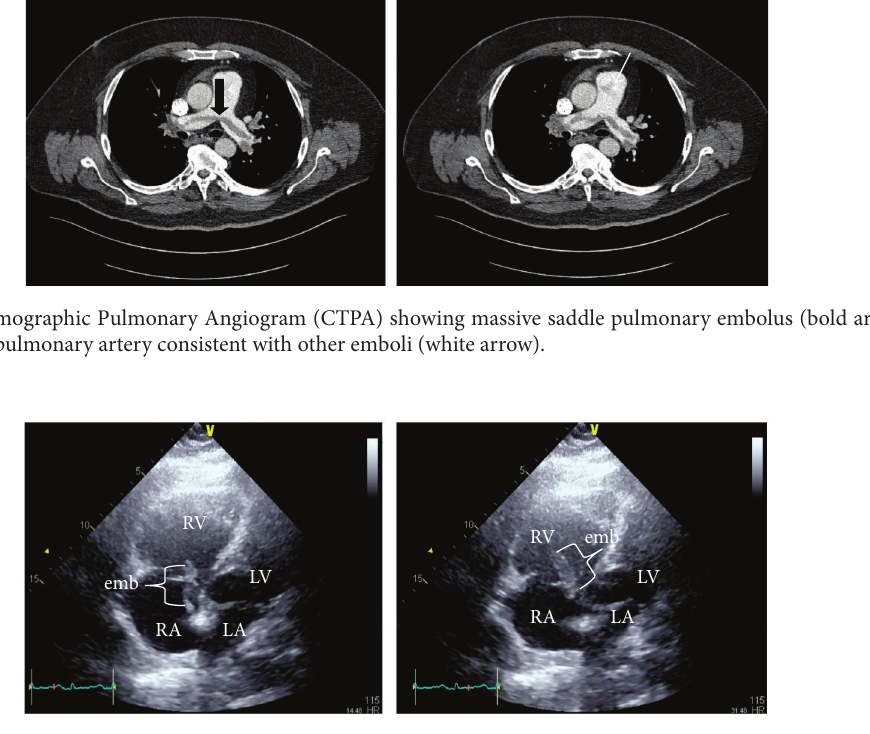
Figure 3: Transthoracic echocardiogram, apical 4-chamber view, showing RV pressure overload with enlarged RV diameter ( > 41mm) and a long echodensity (embolus) attached to TV extending in both RA and RV (RHTVE); LA: left atrium; RV: right ventricle; RA: right atrium; LV: left ventricle; TV: tricuspid valve; emb: embolus; RHTVE: Right Heart Transvalvular Embolus.